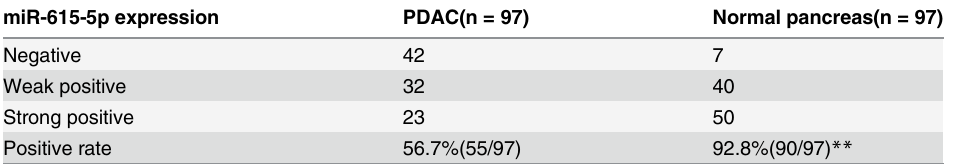
Table 2. miR-615-5p expression in PDAC and normal pancreas tissues determined by locked nucleic acid in situ hybridization (LNA-ISH) miR-615-5p